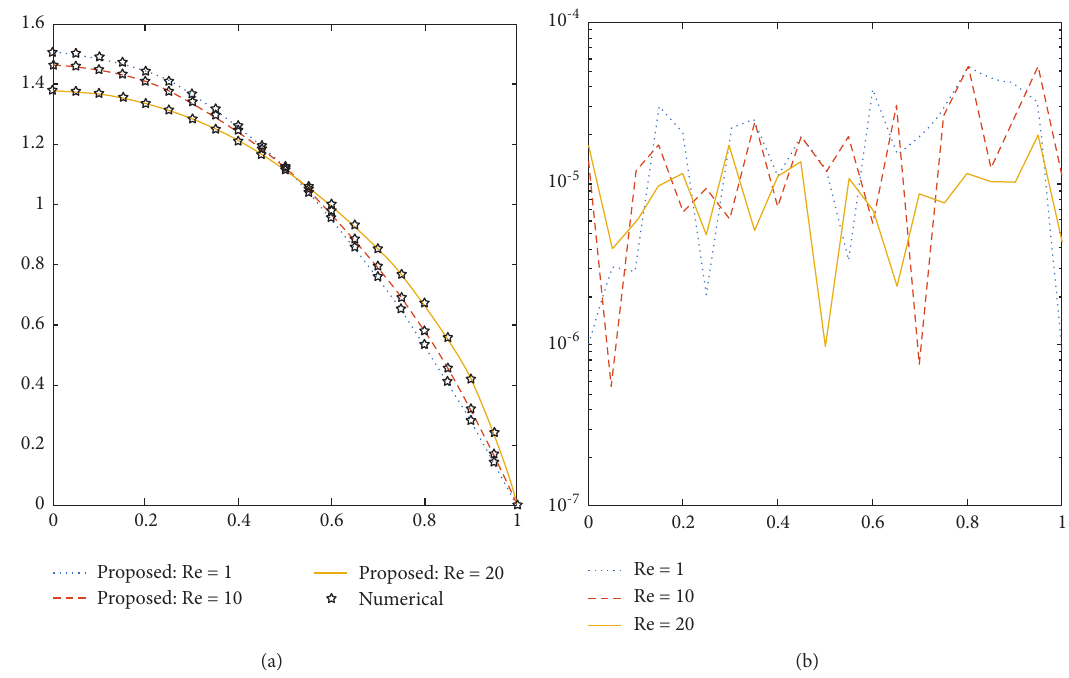
Figure 8: Evaluation of proposed LMA-BANN with the numerical reference results for the MPFPCMI scenario 3: (a) outcomes for different value of Re in f ; (b) error plot of Re in velocity f